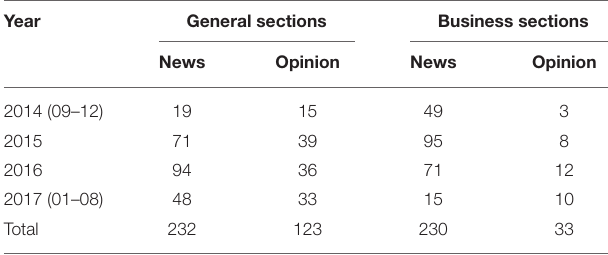
TABLE 5 | Different types of media content over